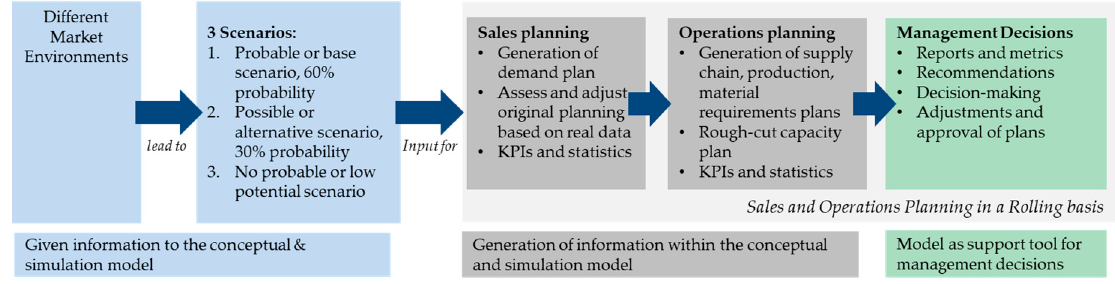
Figure 3. Sales and operations planning (S&OP) plan and management decisions based on potential scenarios (own elaboration).